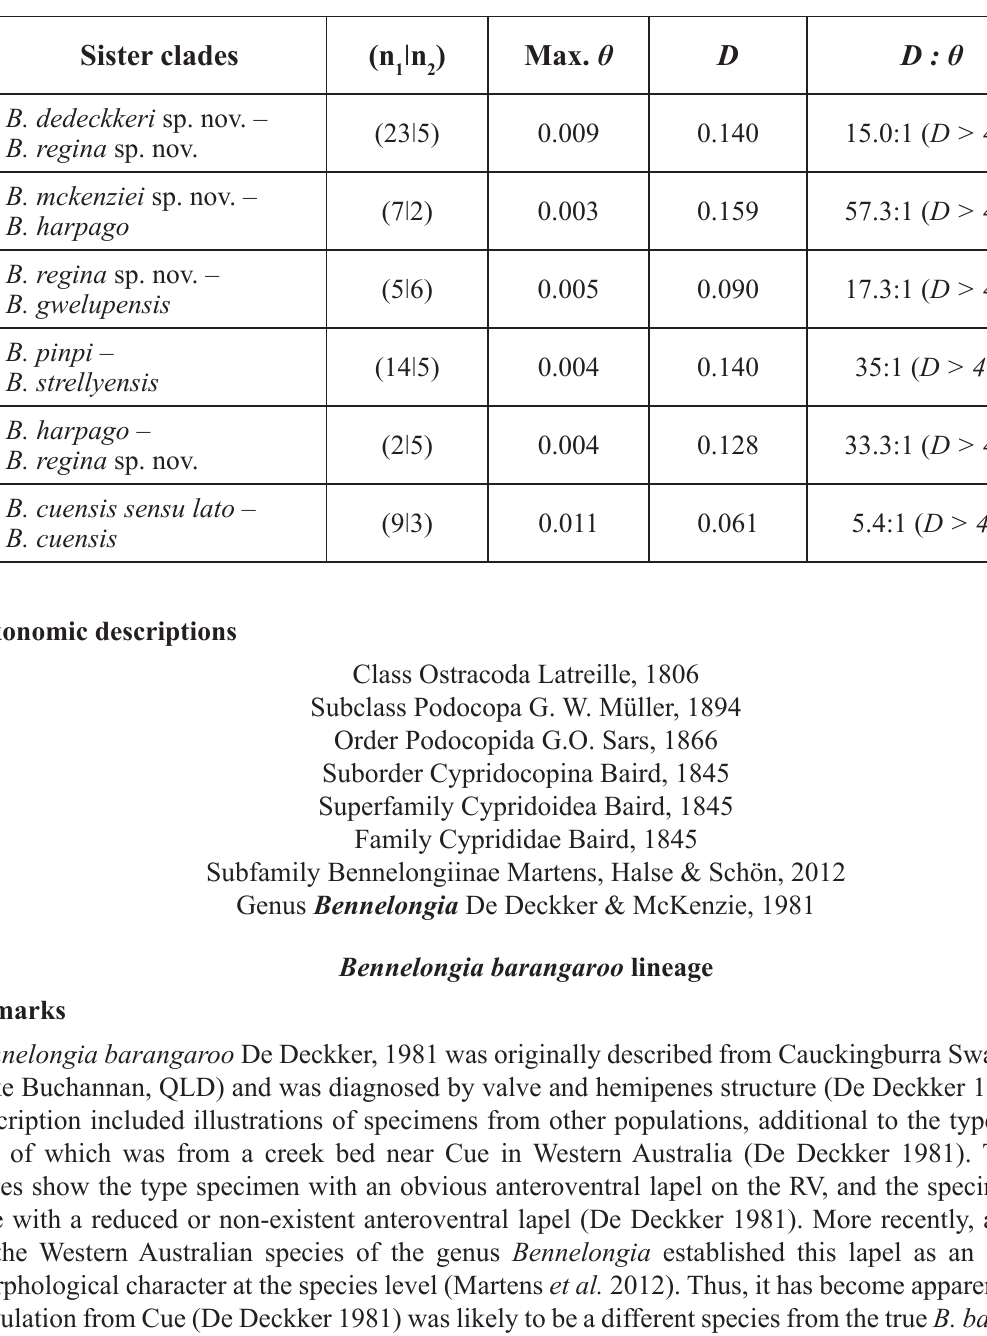
Table 1. Results from calculations for the 4x rule. Following the procedure of Birky et al . (2010), ratios of D to θ are shown for phylogenetic sister clades or the two clades with the lowest mean pairwise distance. In order to fulfil the criteria for the Evolutionary Genetic species concept, this ratio must be equal to or greater than 4. = number of sequences in first sister clade; n = number of sequences in second sister clade; Max. θ = n 1 2 maximum population nucleotide diversity of the two clades; D = mean pairwise distance between each sister clade